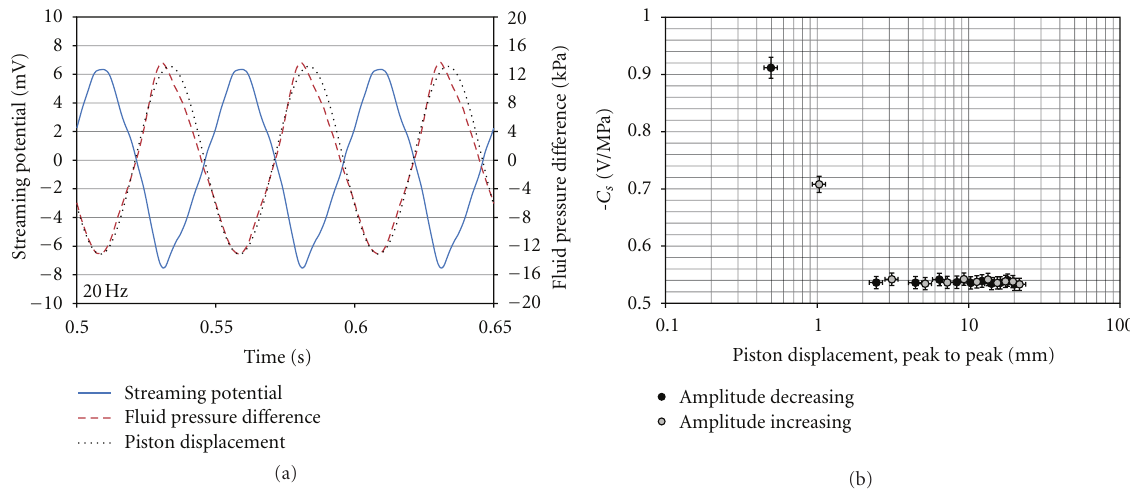
Figure 1: (a) The measured waveforms (streaming potential, fluid pressure and piston position (LVDT)) at 20 Hz. (b) The calculated streaming potential coupling coe ffi cient as a function of piston amplitude at 10 Hz for Ottawa sand saturated with 10 − 3 mol/L NaCl solution at 24 ◦ C ( φ = 0 . 325, κ 10 = 1 . 19 × 10 − 10 m 2 ). The errors in the frequency were calculated from the analysis of a train of approximately 500 cycles, while the errors in the streaming potential coupling coe ffi cient were calculated from the errors in the RMS streaming potential and the measured RMS pressure di ff erence (500